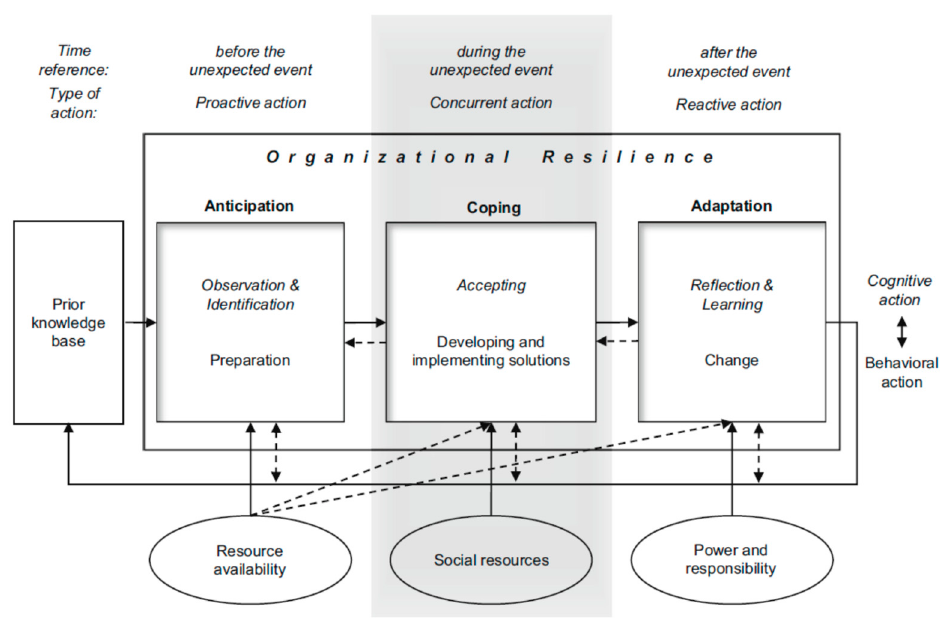
Figure 1. A capability-based conceptualization of organizational resilience. Source: Duchek 2020.